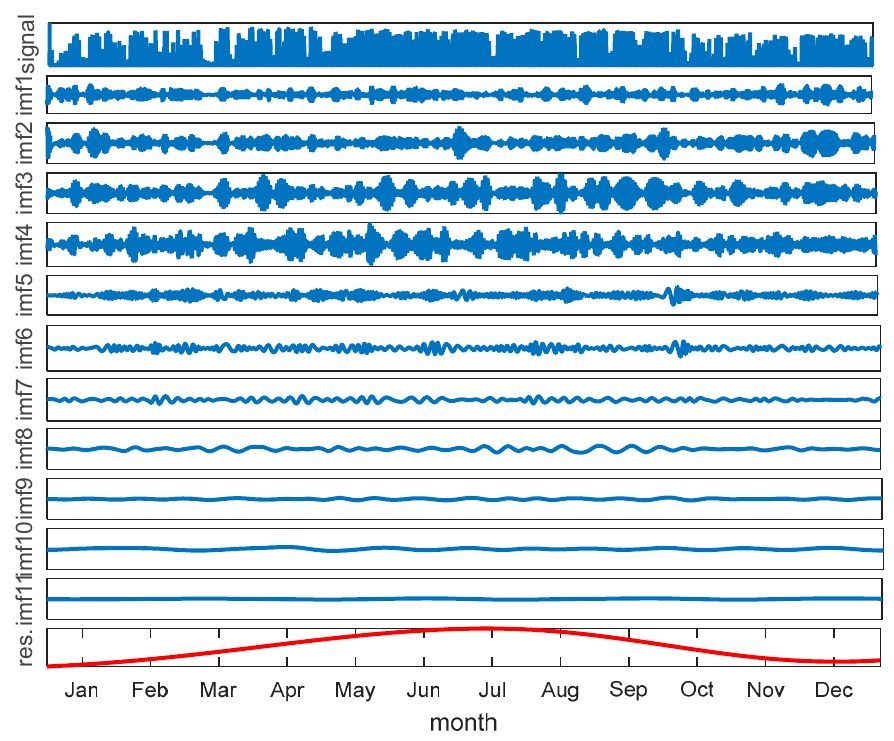
Figure 13. IMFs and residual of the PV generation time series.